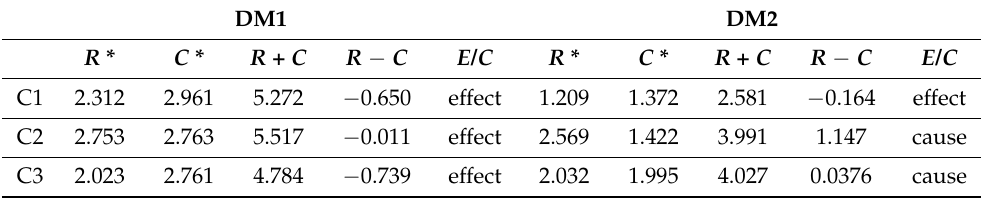
Table 4. DEMATEL total relation matrix—individual